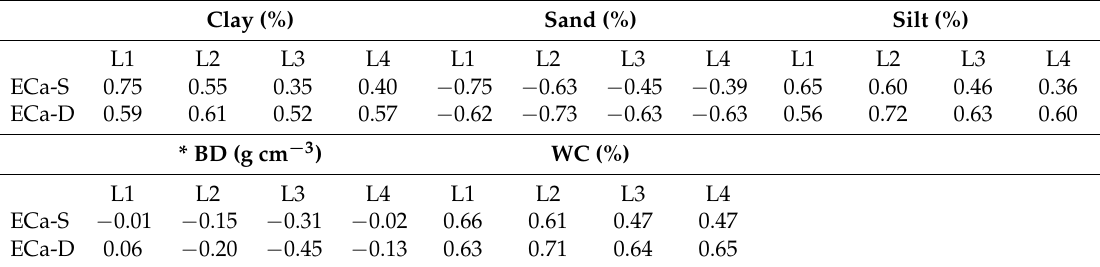
Table 6. Correlation coefficient between soil apparent soil electrical conductivity (ECa, mS m − 1 ) data and soil basic information at the four layers (L1–L4). Clay (%) Sand